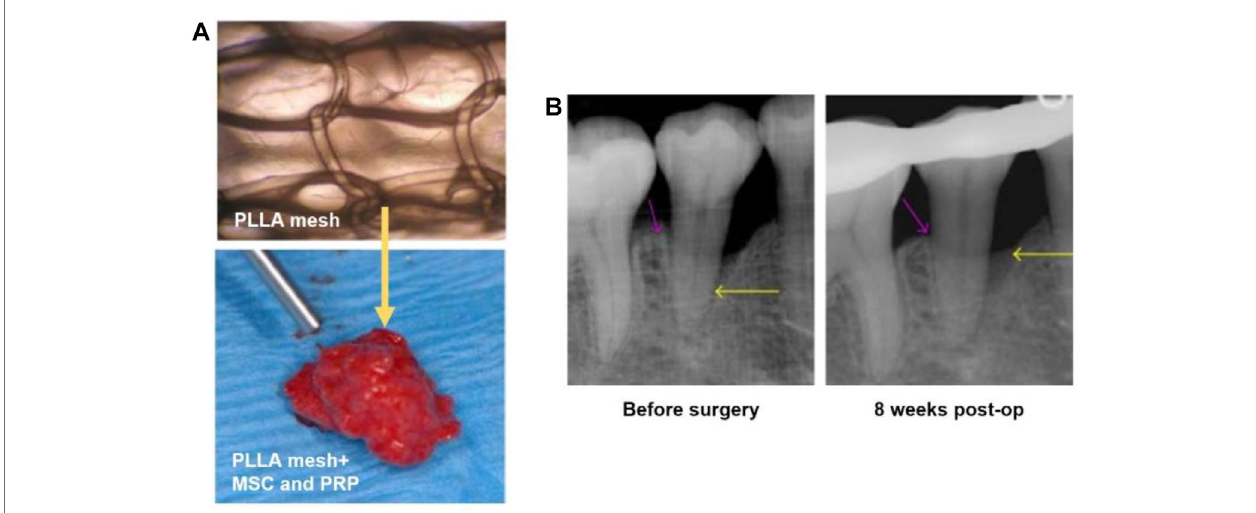
FIGURE 6 | (A) The basket-shaped PLA mesh (top). The BMSCs and PRP were perfused in the PLA mesh for cell delivery (bottom). Reproduced with permission (Baba et al., 2016). Copyright 2016, Shunsuke Baba et al. (B) X-ray images showing the depth ofthe intrabony defects before and at 8 weeks post surgery asindicated by the yellow arrows. Reproduced with permission (Baba et al., 2016). Copyright 2016, Shunsuke Baba et